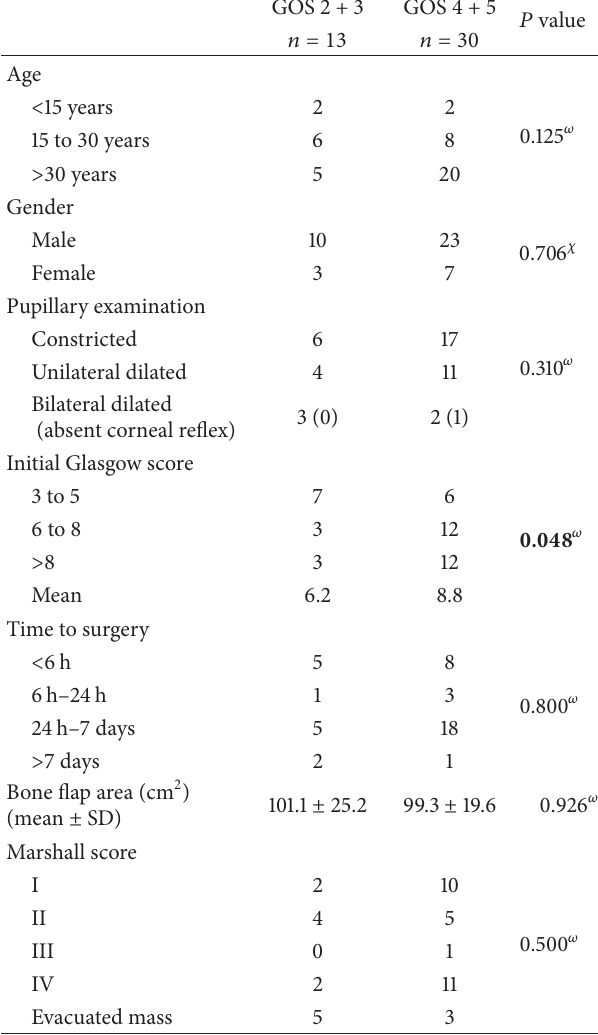
Table 4: Analysis of prognostic factors for functional